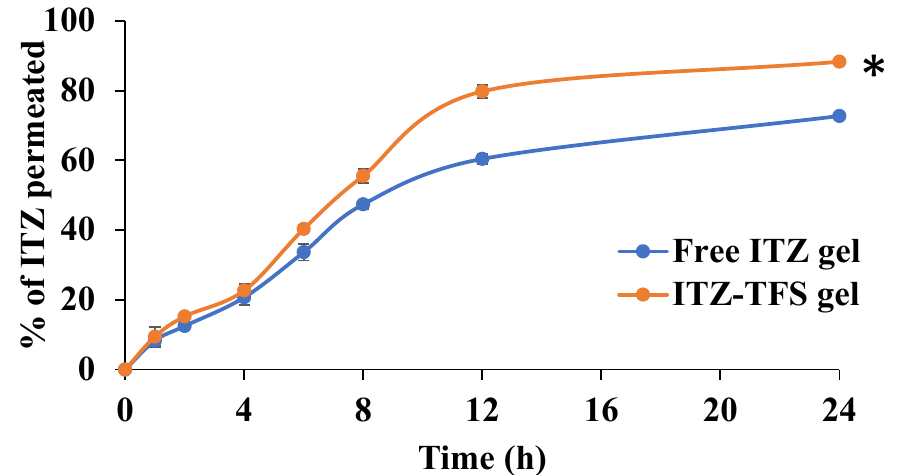
Figure 8. In Vitro permeation study of ITZ from the prepared gels. “*” (p < 0.05) denotes a significant difference between ITZ-TFS gel and free ITZ gel.